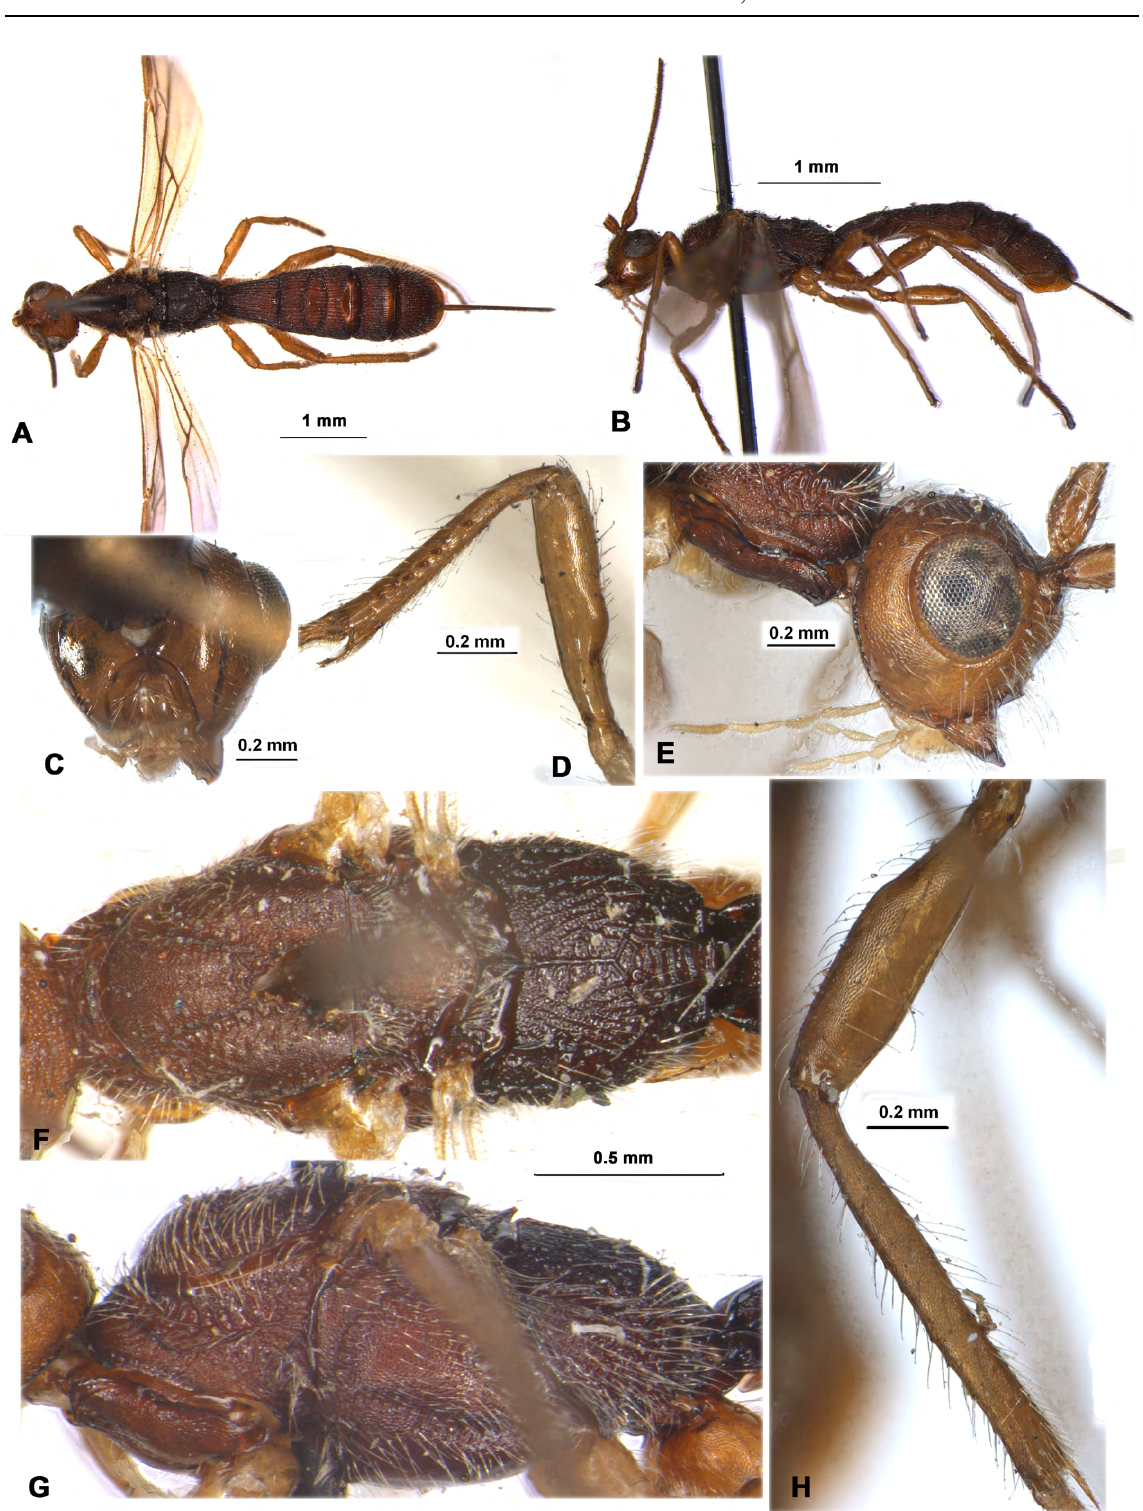
Fig. 8. Euryphrymnus testaceiceps Cameron, 1910, ♀, holotype, MHBG. A . Habitus, dorsal view. B . Habitus, lateral view. C . Head, latero-posterior view. D . Fore leg. E . Head, lateral view. F . Mesosoma, dorsal view. G . Mesosoma, lateral view. H . Hind